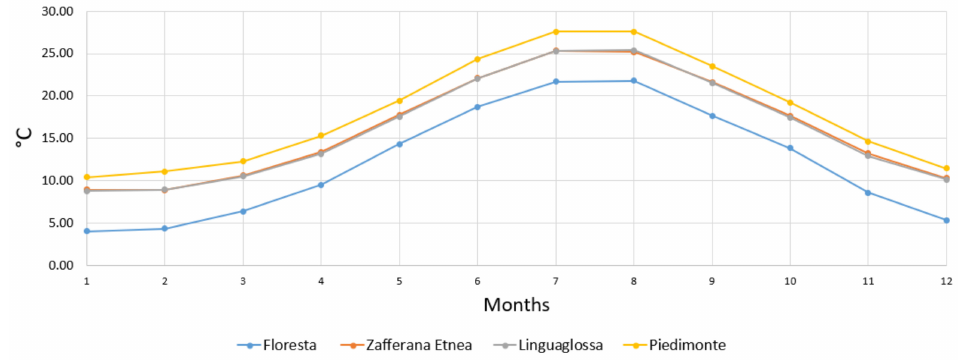
Figure 3. Mean monthly temperatures (1981–2000).